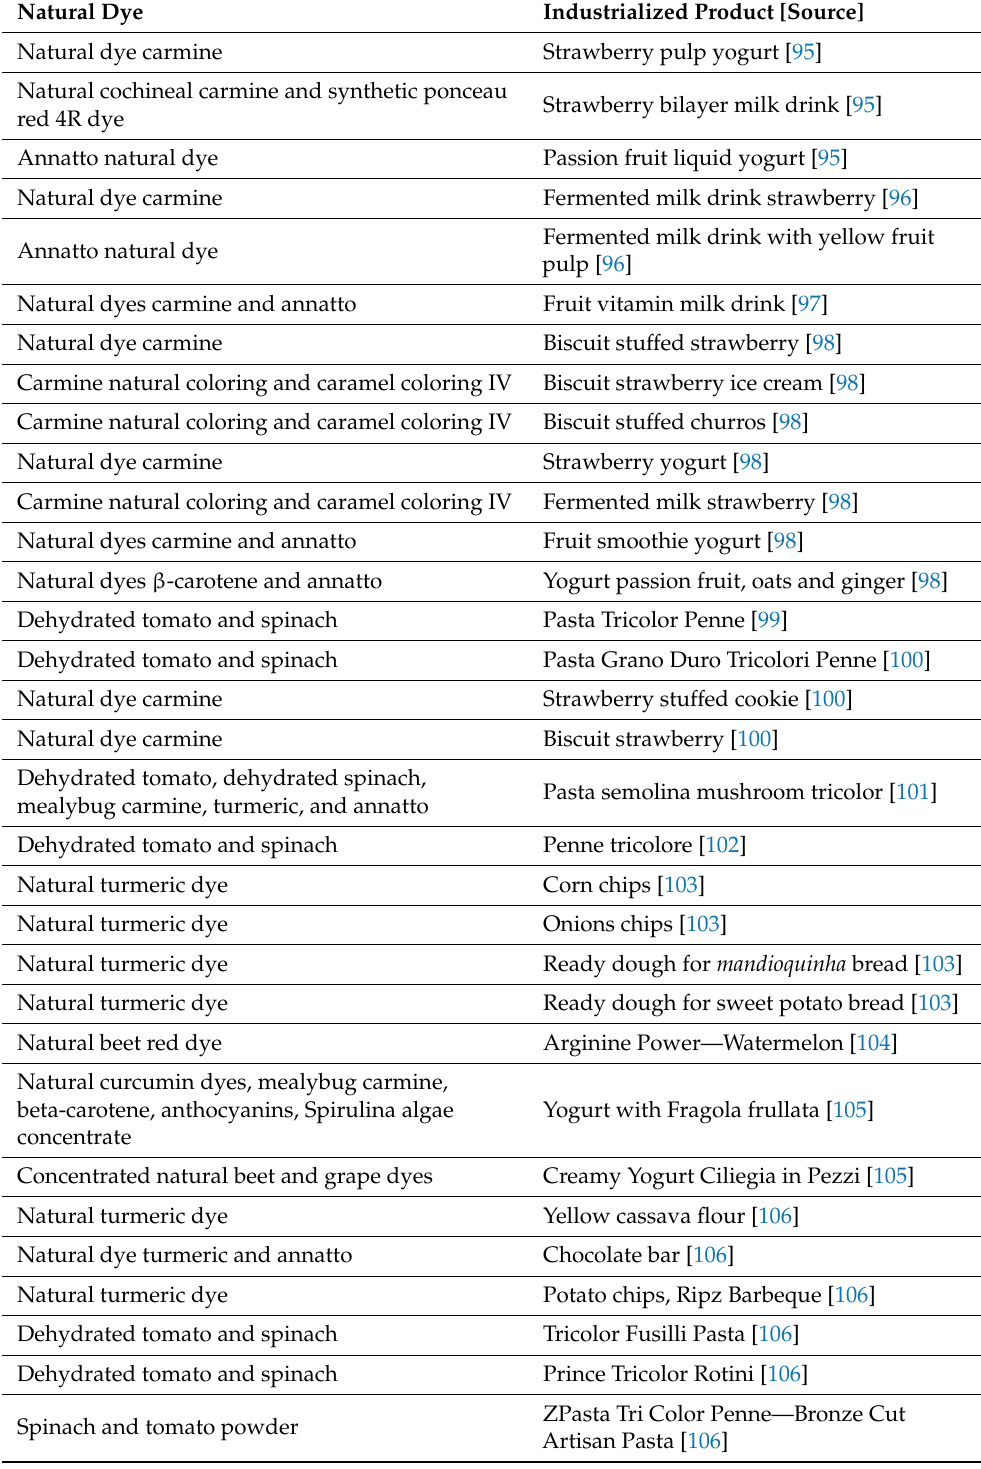
Table 3. Industrialized products with natural dyes according to manufacturers’